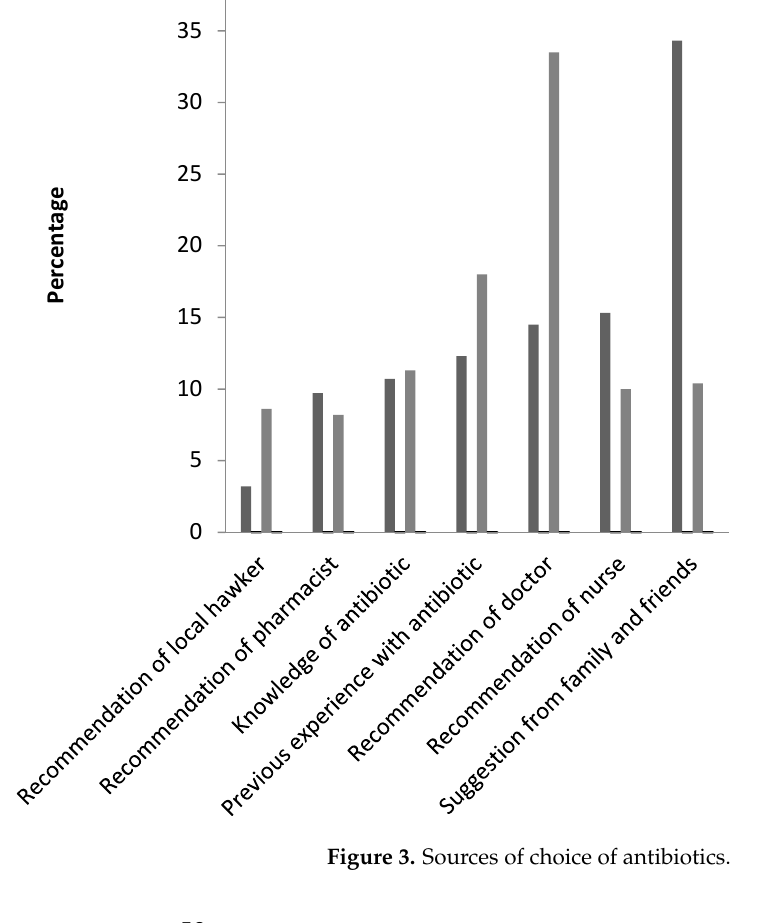
Figure 3. Sources of choice of antibiotics.